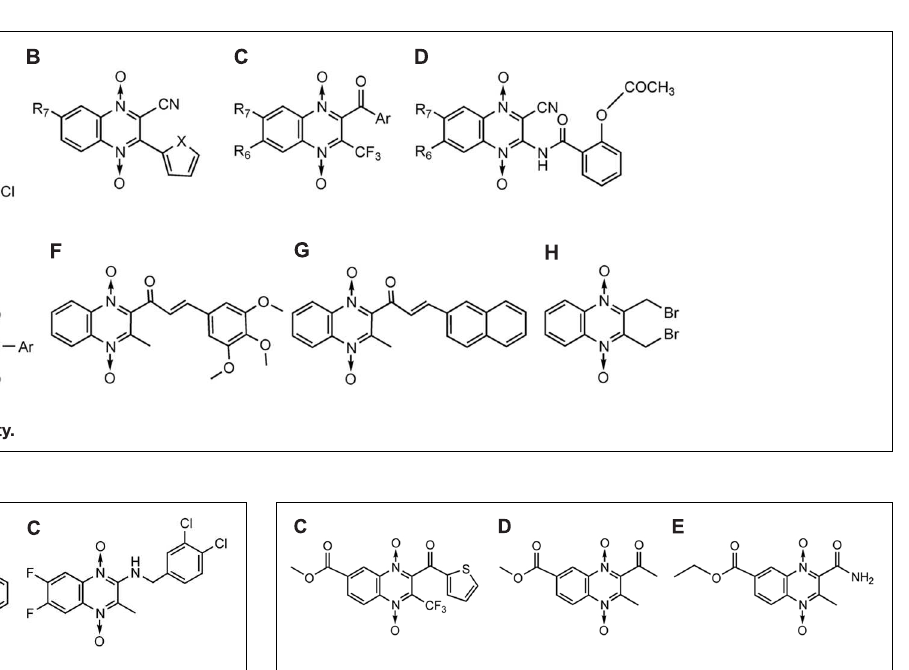
FIGURE 11 | QdNOs with antiamoebic